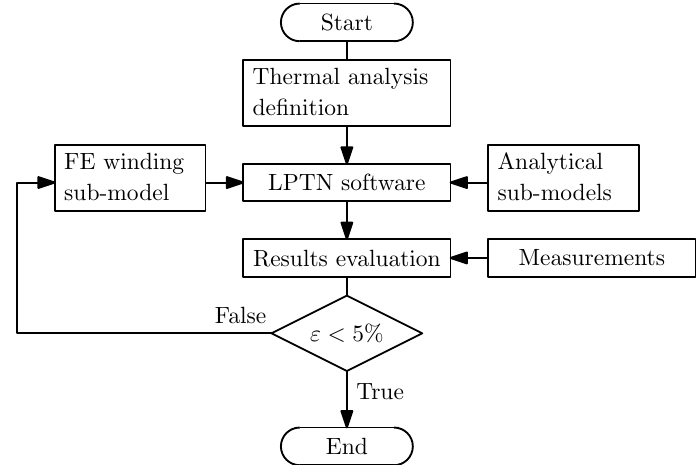
Figure 2. Flowchart of the thermal